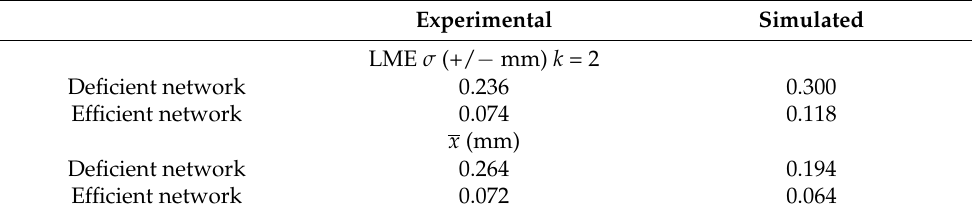
Table 3. Comparison between the experimental results and simulations, comparing the influence of the network with respect to the standard deviation of the maximum LME and the average maximum error.